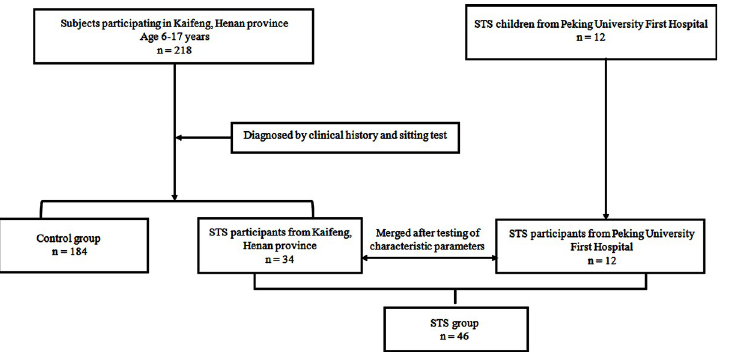
Fig 1. Flowchart of participant selection. STS, sitting-induced tachycardia